Question: In one sentence, what is this figure communicating?
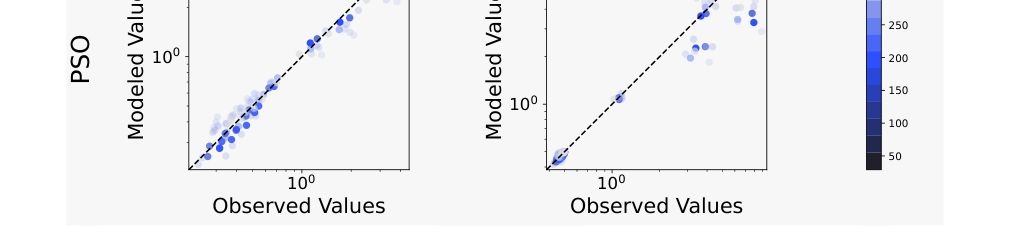
Answer: Goodness of fit for mean (left columns) and standard deviation (right column) in the Immunology and Inflammation therapeutic area, with the indication for a given plot indicated by abbreviation on the left axis. All plots report on the principle cohort identified in Table 7. The mean and standard deviation for all change from baseline longitudinal outcomes are evaluated at discrete time bins indicated by the color bar for both the data and the digital twins. As the twins should represent the data well, we ideally expect the markers to for either moment to all lie on the dotted diagonal line.